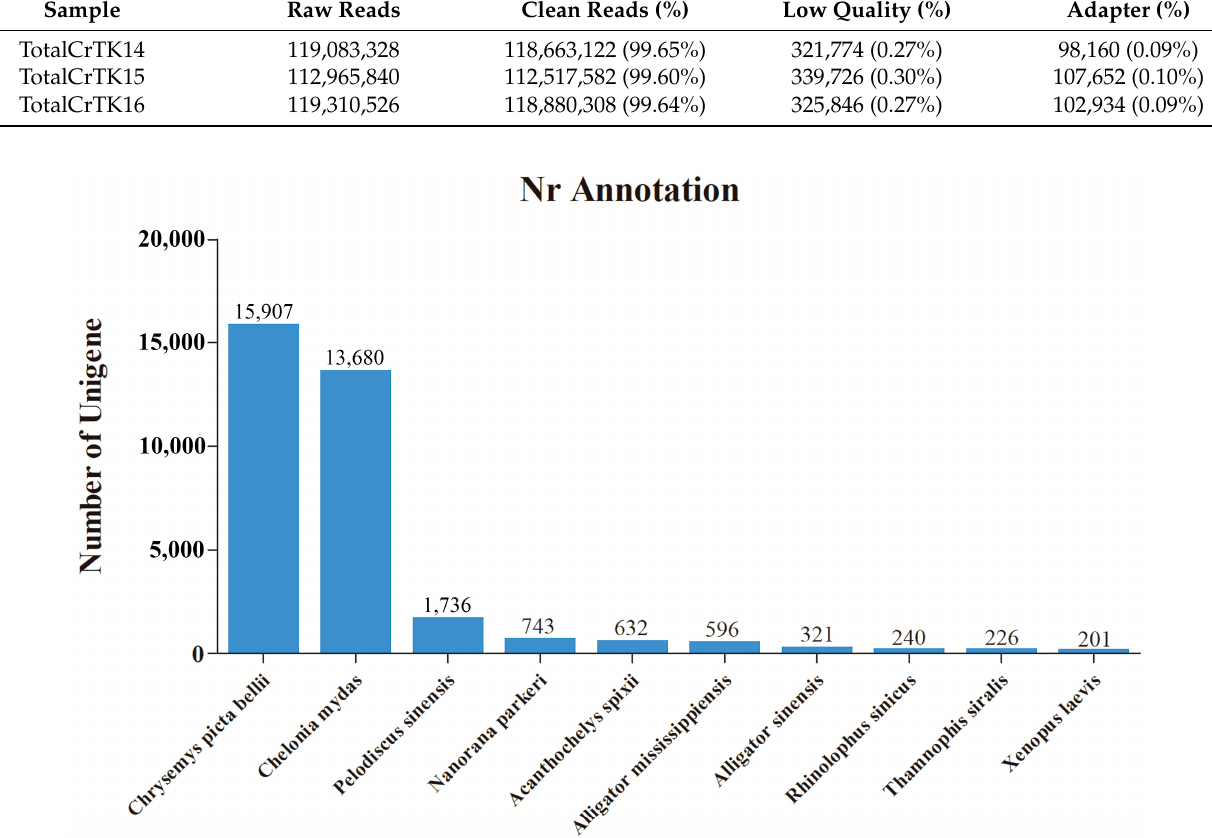
Figure 1. Top 10 homologous sequences of the unigenes from the CR tissues of M. reevesii which were annotated in the NCBI non-redundant protein (Nr) database (with an E-value threshold